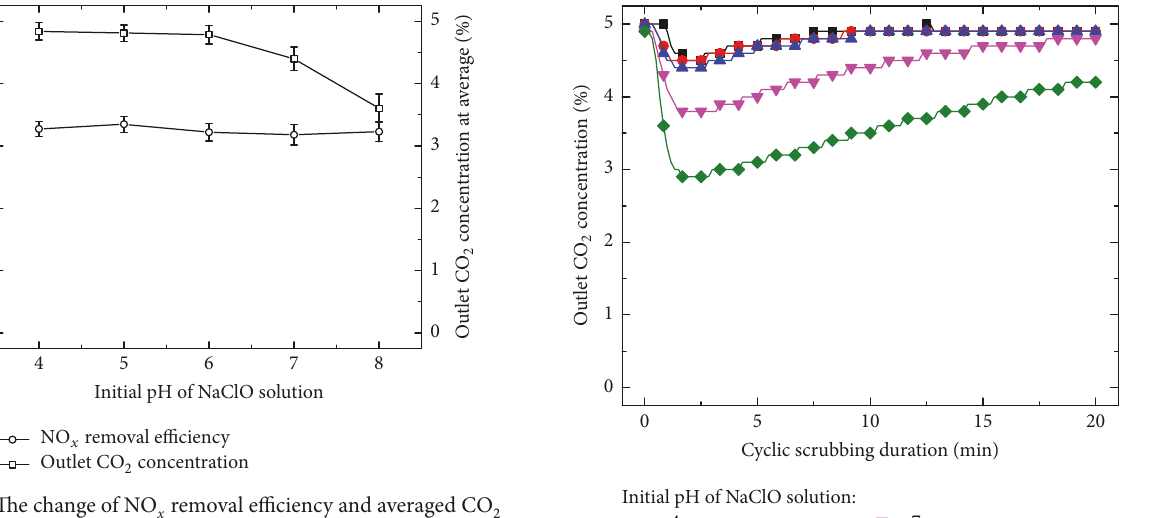
Figure 6: The change of NO removal efficiency and averaged CO 2 x concentration in flue gas with initial pH (gas flow is 1.25 L/min, inlet NO concentration is 1000ppm, initial CO 2 concentration is 5%, x NaClO concentration is 0.05 M, and solution temperature is 293 K). Figure 7: The change of CO 2 concentration during the cyclic scrubbing duration (gas flow is 1.25 L/min, inlet NO concentration is 1000 ppm, initial CO 2 concentration is 5%, NaClO concentration is 0.05 M, and solution temperature is 293